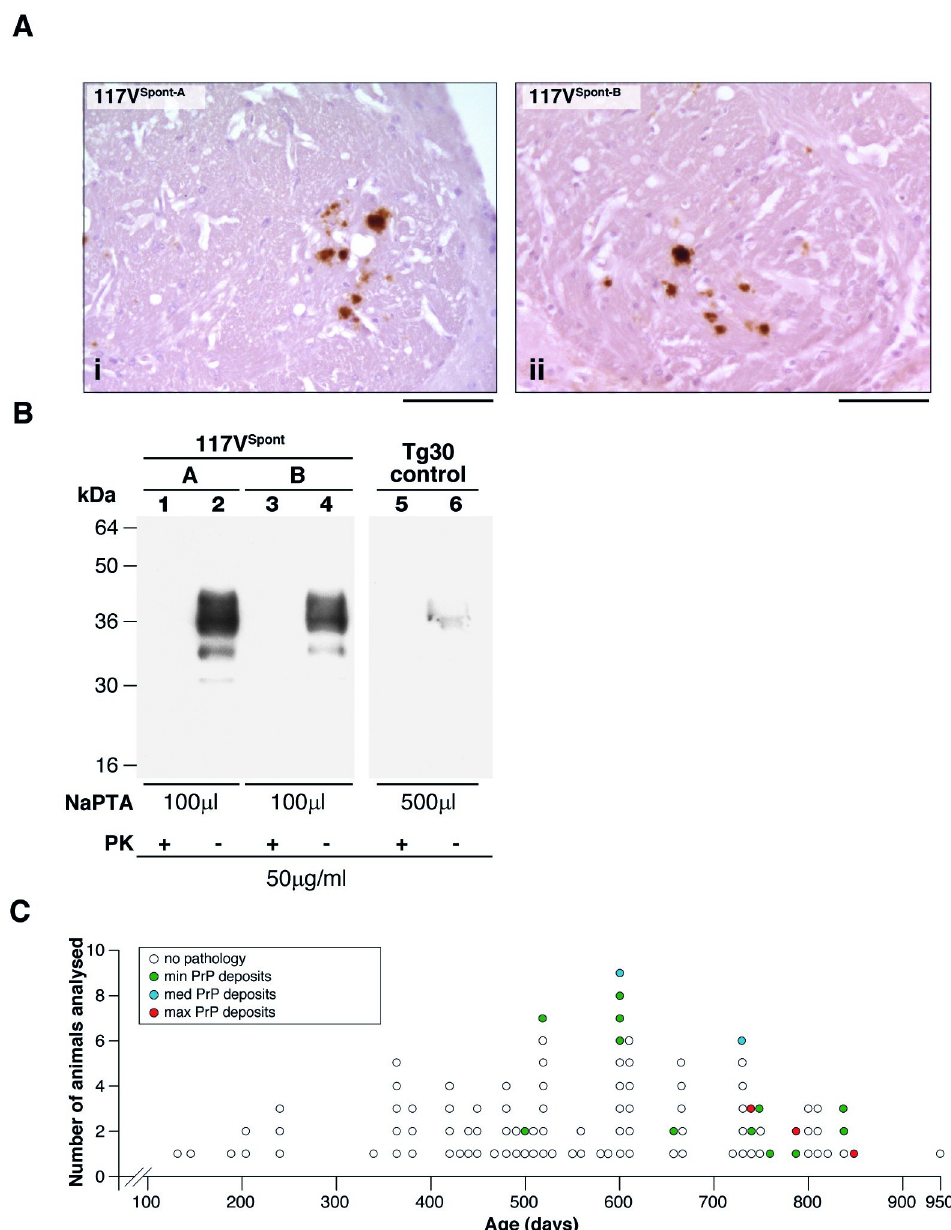
Fig 1. Characterisation of abnormal PrP deposition in the brain of uninoculated 117VV Tg30 transgenic mice. (A, i and ii) IHC using anti-PrP monoclonal antibody 3F4 showing PrP plaques in the anterior commissure of the brain of aged 117VV Tg30 mice. (Ai) 117V Spont-A mouse that developed neurological disease at 476 days of age. (Aii) 117V Spont- B mouse culled at 734 days without neurological symptoms. Scale bar, 300 μ m. (B) Immunoblot developed with anti- PrP monoclonal antibody ICSM 35 (epitope human PrP residues 93–105) and high sensitivity chemiluminescence showing insoluble PrP recovered after NaPTA-precipitation of 10% (w/v) brain homogenate. Lanes 1 and 2, 117V Spont- A brain; lanes 3 and 4, 117V Spont-B brain; lanes 5 and 6, age-matched control 117VV Tg30 brain that was devoid of PrP plaques when analysed by IHC. The volumes of 10% (w/v) brain homogenate from which NaPTA pellets were derived are shown in microliters ( μ L). NaPTA pellets in lanes 1, 3, and 5 were digested with proteinase-K under standard conditions (PK+), and the entire processed sample was loaded on the gel. Samples in lanes 2, 4, and 6 were analysed without PK digestion (PK − ) and 20% of the processed NaPTA pellet loaded on the gel because this produced PrP signal intensities that fall within the linear range of the chemiluminescent substrate. (C) Graphical representation of the incidence and severity of spontaneous PrP plaque deposition in brain of uninoculated 117VV Tg30 mice versus age (S1 Data). Brain was examined by IHC using anti-PrP monoclonal antibody ICSM 35. Representative examples of